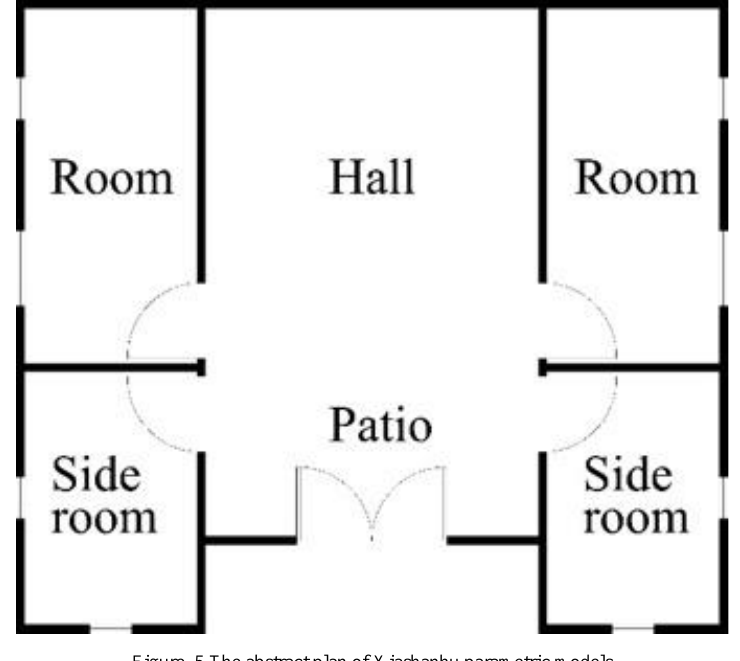
Figure. 5 The abstract plan of Xiashanhu parametric models